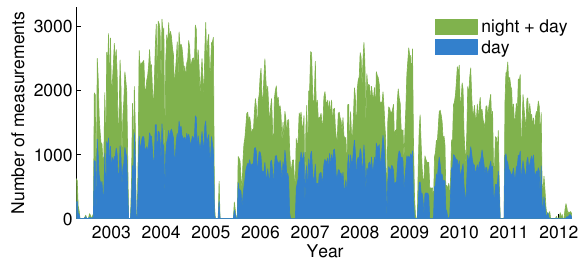
Figure 3. Number of GOMOS nighttime and GBL measurements (weekly).